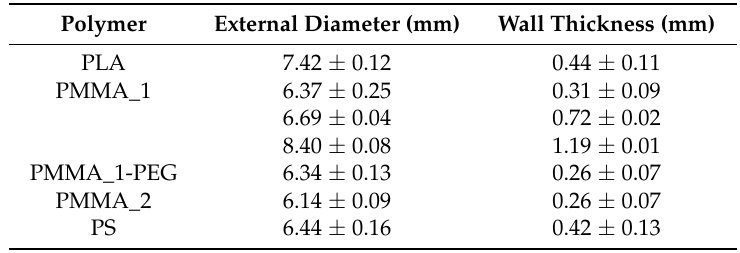
Table 3. Average dimensions of the capsules used for the experimental tests.